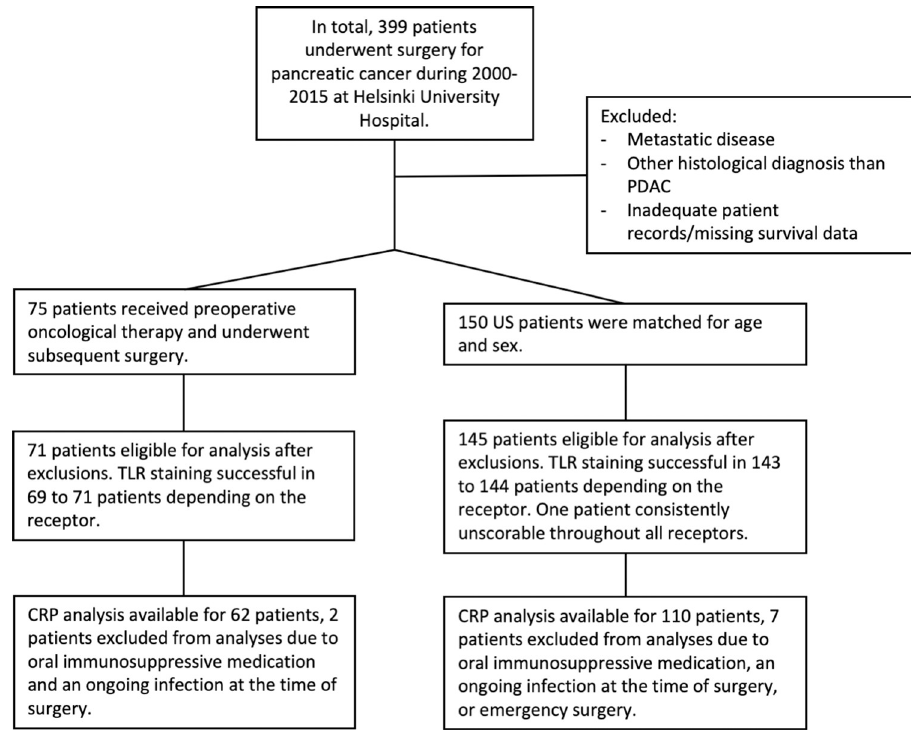
Fig 1. Flow chart of patients. This figure shows the number of patients at each stage of analysis. US = upfront surgery.